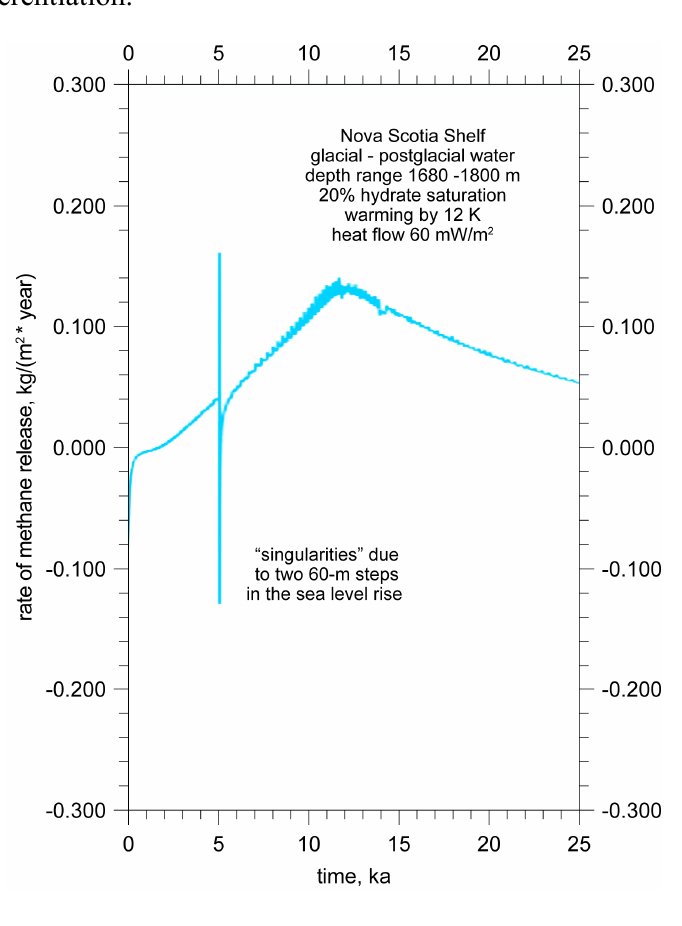
Figure 19. Model methane release rate (kg m − 2 yr − 1 ) history for the Atlantic Margin offshore for a current 1680–1800 m water depth. The sharp oscillations are an artifact caused by linear interpolation of temperature between the nodes of the depth grid during the numerical